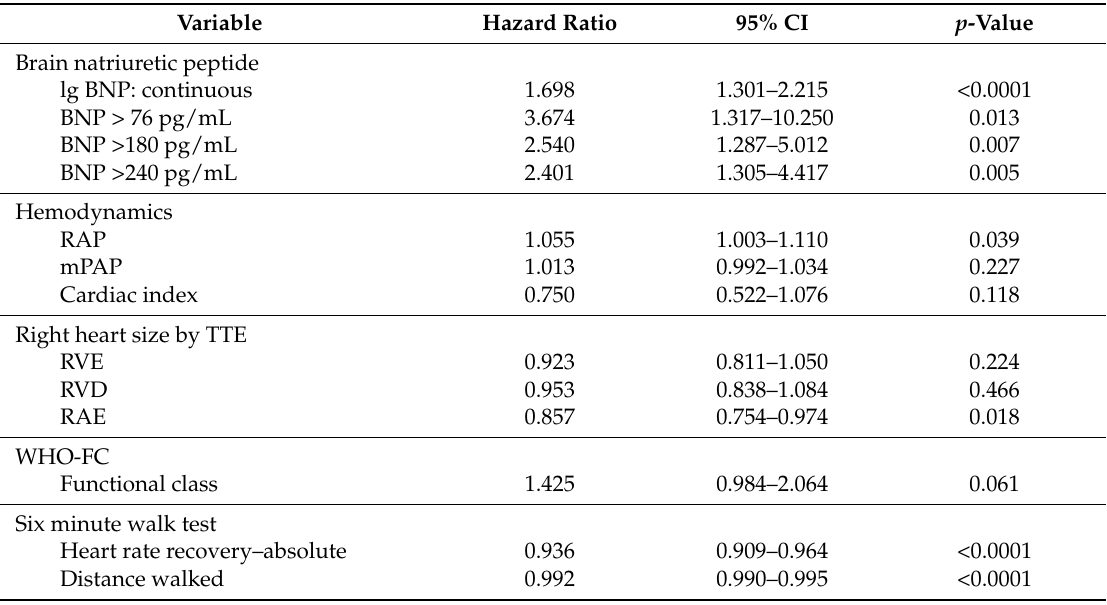
Table 3. Univariate analysis predictors of mortality in PAH patients.